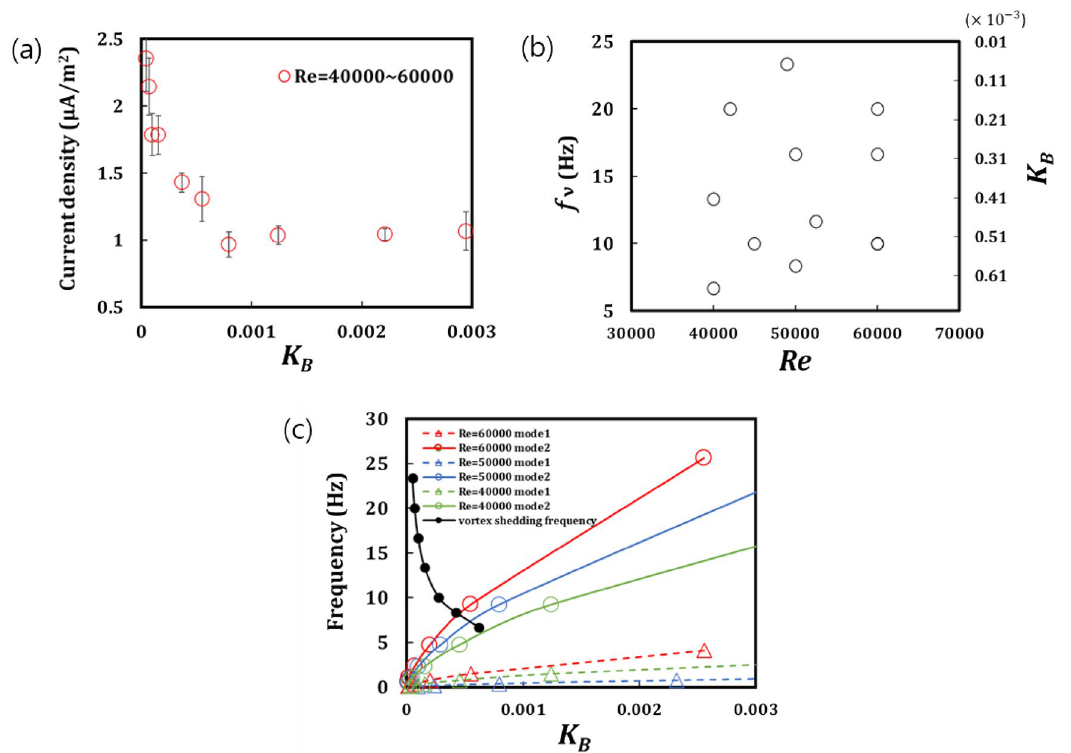
Figure 5. ( a ) Plot of the current density as a function of K B measured in the Re range of 40,000 to 60,000. ( b ) Vortex shedding frequency and K B as a function of Re . ( c ) Natural frequency of PENG and the vortex shedding frequency as a function of K B